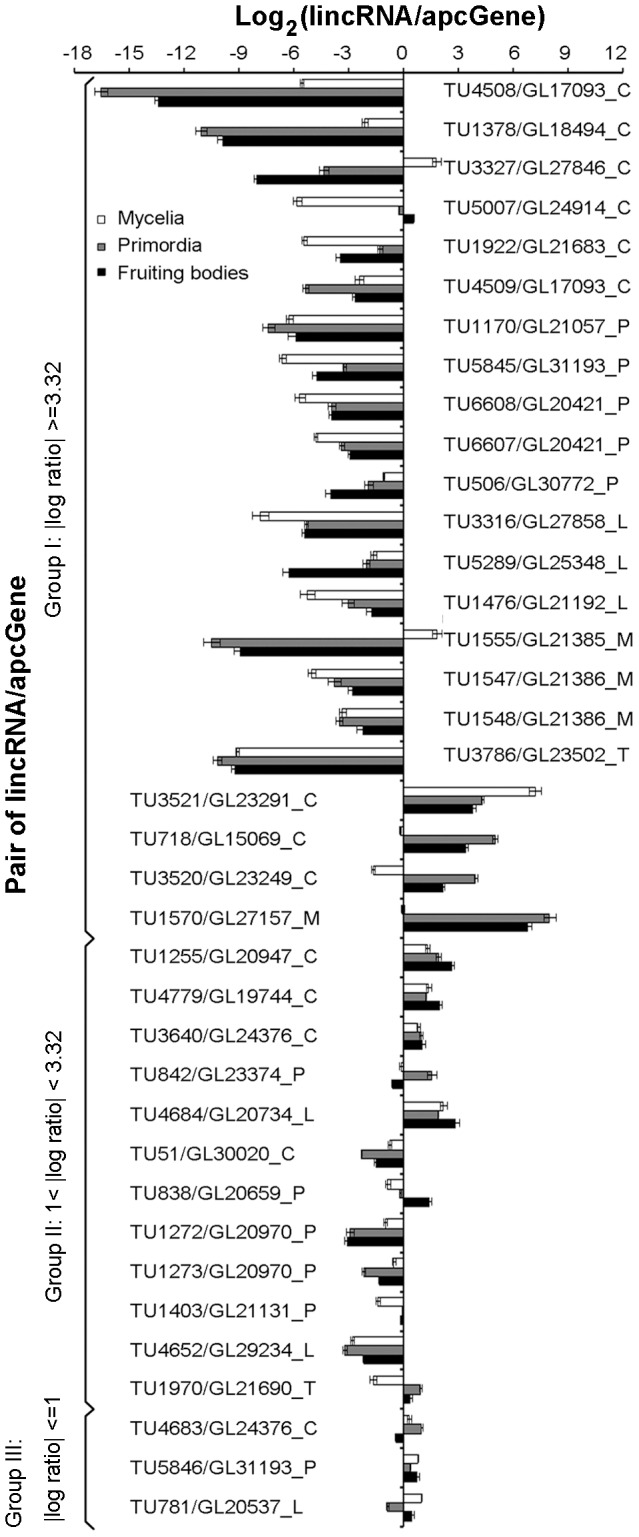
Relative expression levels of lincRNAs and their apcGenes across the three developmental stages.The X axis shows the log ratio abundance for lincRNA/apcGene determined by qPCR. The Y axis lists the pair of lincRNA and apcGene. The lists are sorted based on the log ratio abundance and divided into three groups (I, II and III). The IDs of the lincRNAs and their apcGenes are shown to the right or left of the graph. The postfixes indicate the families or pathways to which the apcGenes belong. C: CAZy protein family; P: CYP450 protein family; L: lignin degradation pathway; M: matB genes; T: triterpenoid synthesis pathway. Error bars denote the standard deviations of three qPCR replicates.